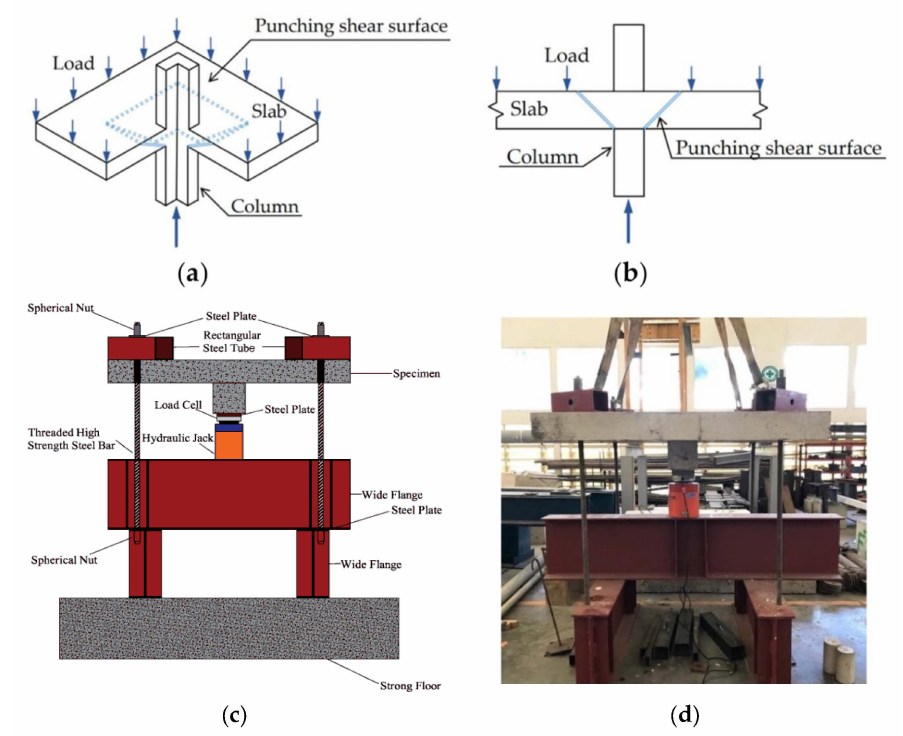
Figure 2. Two-way shear ( a ) failure isometric view; ( b ) failure elevation; ( c ) loading test setup schematic; ( d ) actual loading test setup [43,44]. Table 2. Experimental database for RC slabs with FRP reinforcements under two-way shear